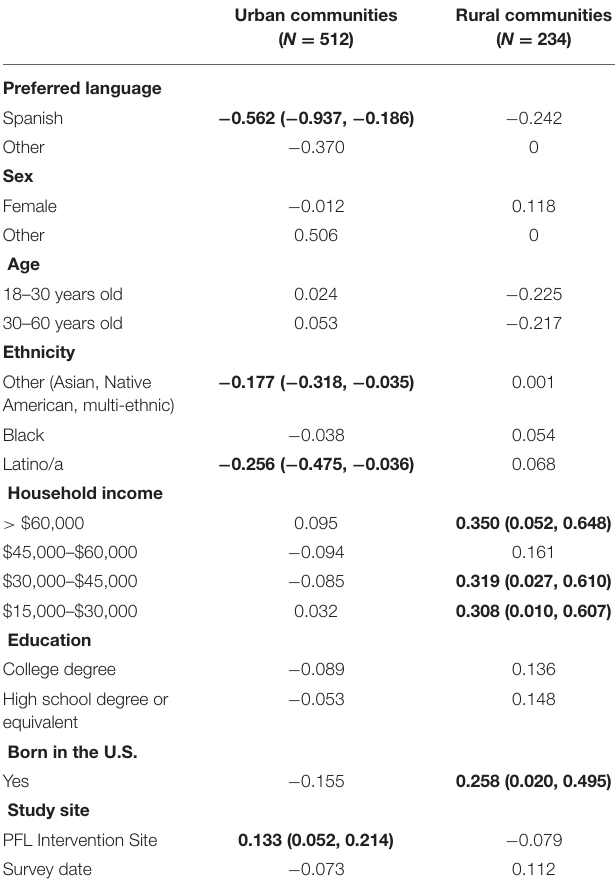
TABLE 4 | Generalized Estimating Equations to examine how the presence of PFL in an urban and rural community influences aggregated measures of perceived access to pet